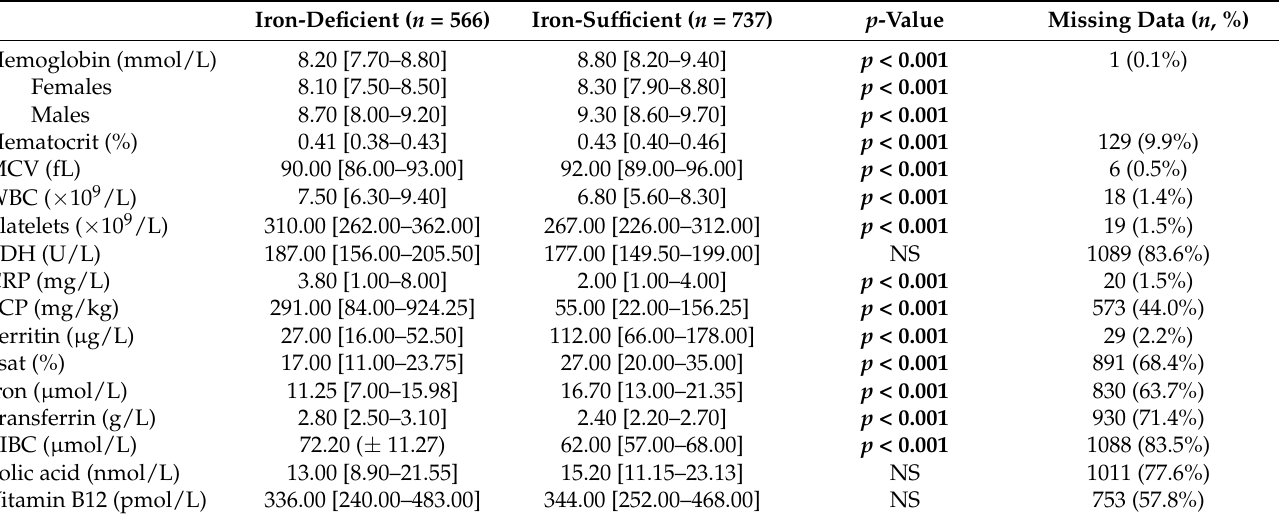
Table 2. Differences between patients with Inflammatory Bowel Disease stratified by iron status. Iron-Deficient ( n = 566) Iron-Sufficient ( n = 737) p